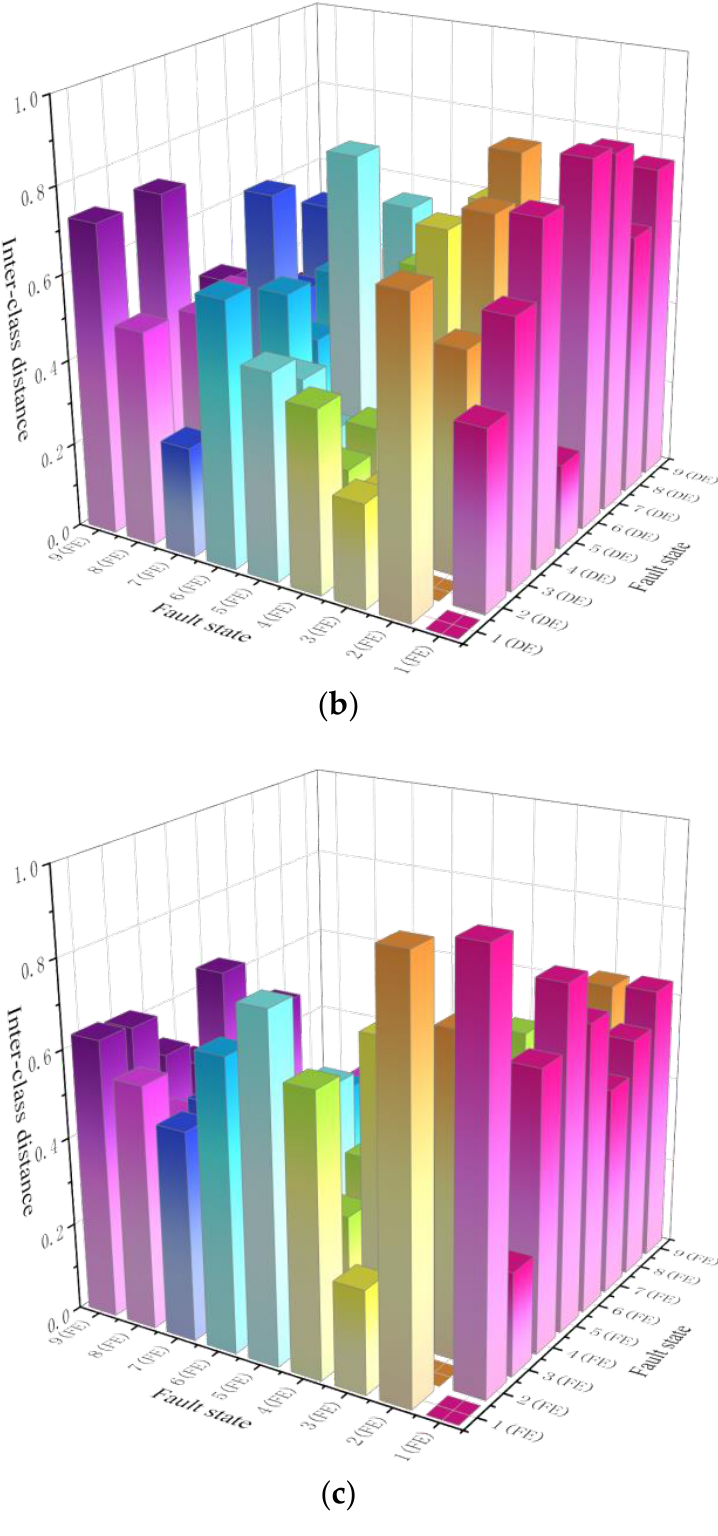
Figure 6. Inter-class distance S b between different fault states. ( a ) DE-DE inter-class distance S b . ( b ) DE-FE inter-class distance S b . ( c ) FE-FE inter-class distance S b .